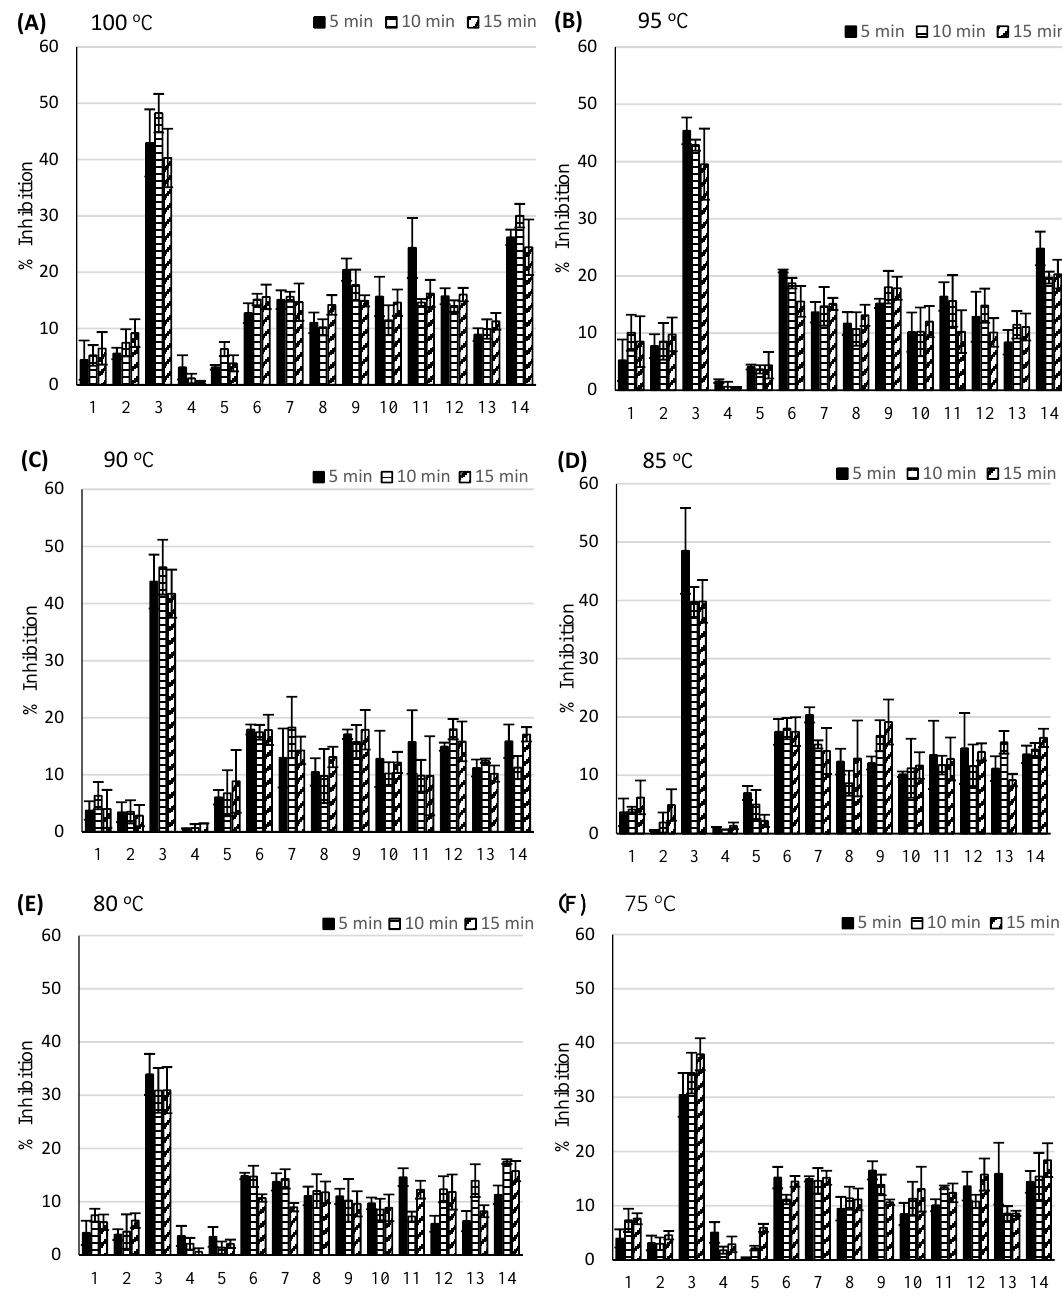
Figure 1. Acetylcholinesterase (AChE) inhibition (%) in the studied teas (averaged results ± standard deviation). ( A – F ) represent brewing temperatures. Legends: 1- Biofix Tea Raspberry, 2- Biofix Tea Multi-fruit, 3- Biofix Tea Wild Strawberry, 4- Biofix Tea Cranberry, 5- Biofix Tea Wild Rose, 6- Biofix Green Tea with Quince, 7- Biofix Green Tea Guarana and Passion, 8- Biofix Green Tea Ginseng and